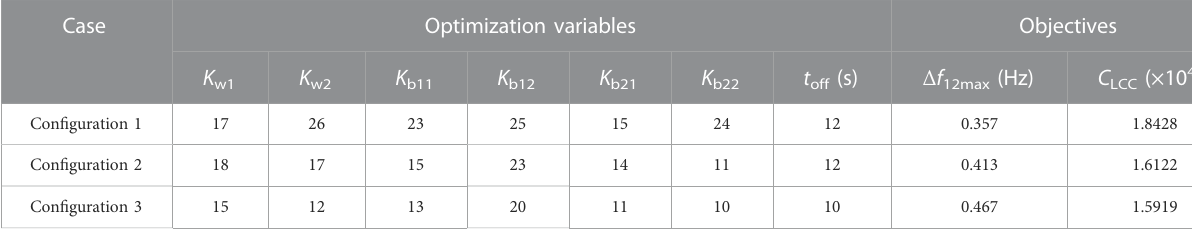
TABLE 2 Optimization results considering SFD.